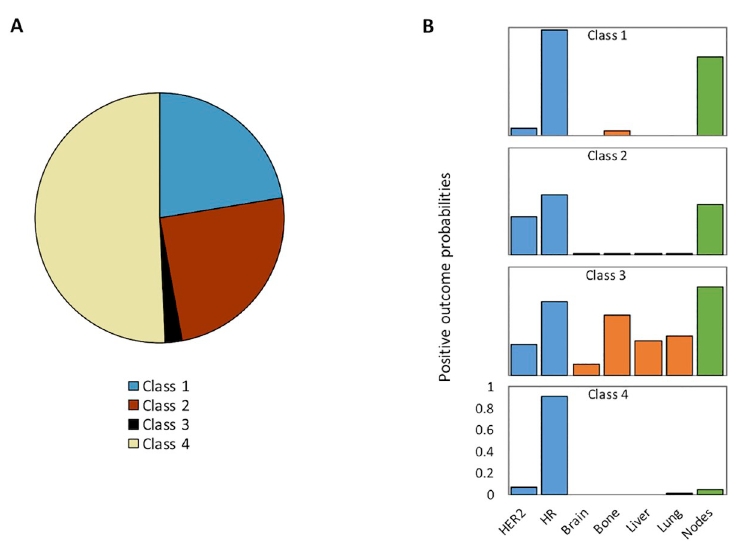
Fig 1. LCA model output. A: Probabilistic distribution of patients by latent class. Note that this represents the probability of a patient being classified in each subgroup, and is not equivalent to the distribution of cases in this study (Table 3). B: Outcome probabilities for each class. Each bar represents the probability of a parameter being positive in a particular class. Bars are colour coded based on the following groupings: HR/HER2 subtype (blue), distant organ metastases (orange), and lymph node metastases